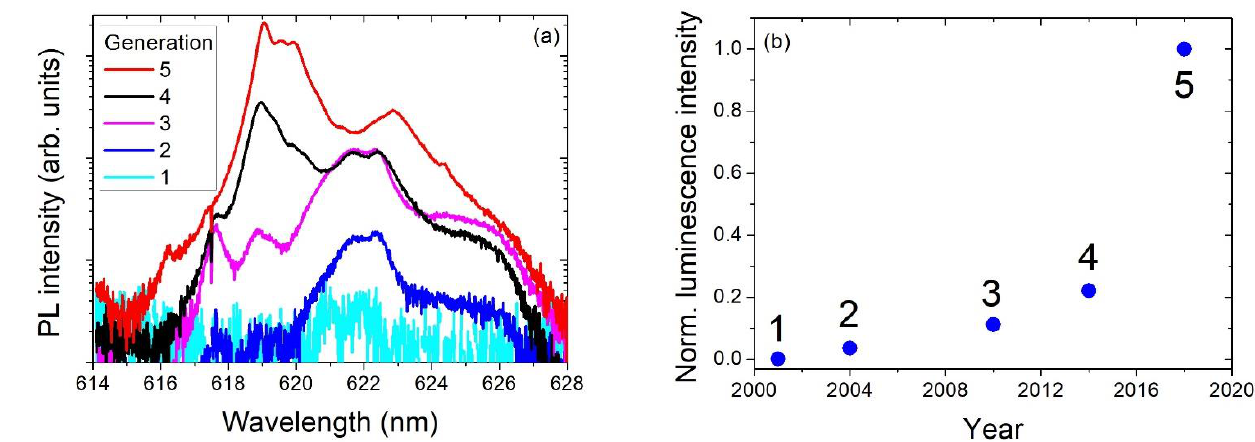
Figure 7. Typical RT photoluminescence (PL) spectra ( a ) and normalised RT luminescence intensity ( b ) for the five generations of Eu-implanted GaN. Generation 1: simple furnace annealing or rapid thermal annealing at ~1000 °C; generation 2: AlN capping allows annealing up to ~1300 °C; generation 3: HTHP annealing up to 1400 °C; generation 4: Mg co-doping and HTHP annealing up to 1400 °C; generation 5: Mg co-doping and HTHP annealing up to 1600 °C.